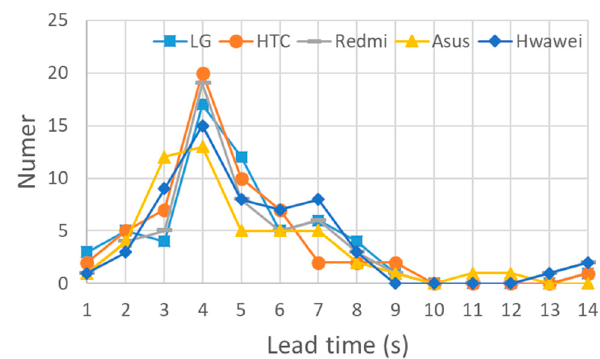
Figure 12. The distribution of lead times of both worldwide and Meinong strong motion datasets for different smartphones.